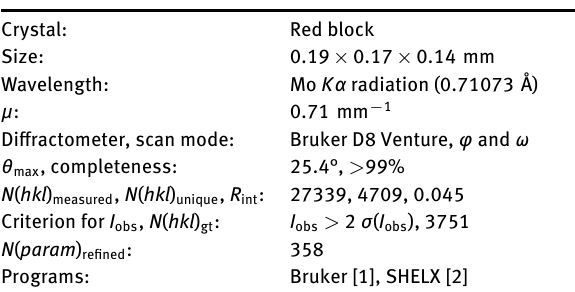
Table 1: Data collection and handling.